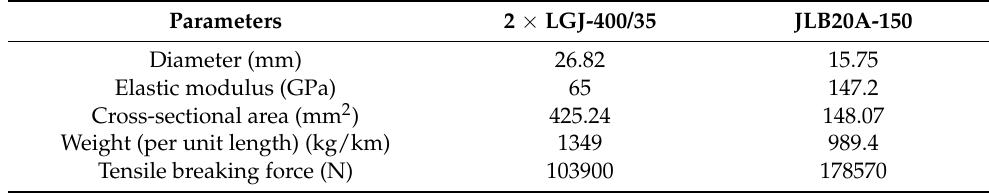
Table 1. Material parameters of the conductor and ground wire.